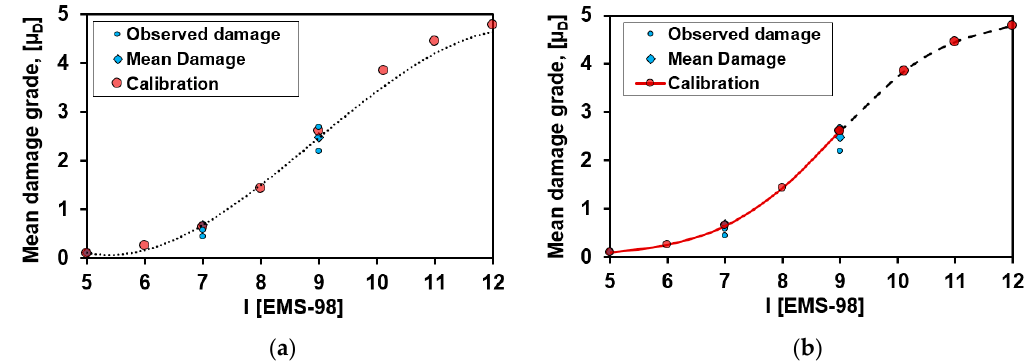
Figure 17. Calibration of vulnerability curves: ( a ) interpolating polynomial function; ( b ) representation of the proposed curve.